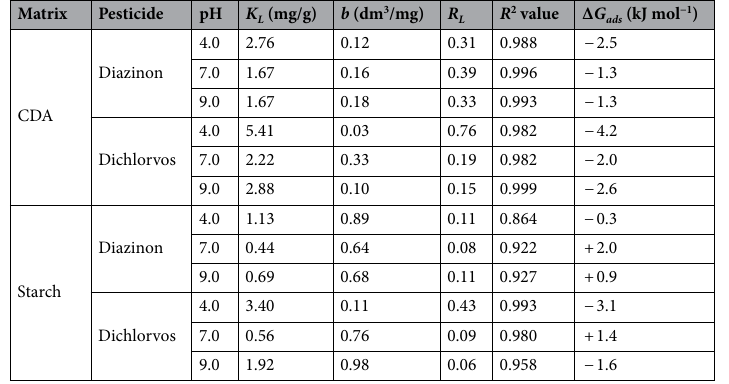
Table 2. Langmuir parameters (derived from the plots in Fig. 2) for the adsorption of diazinon and dichlorvos on CDA and starch surfaces at 27 °C and different